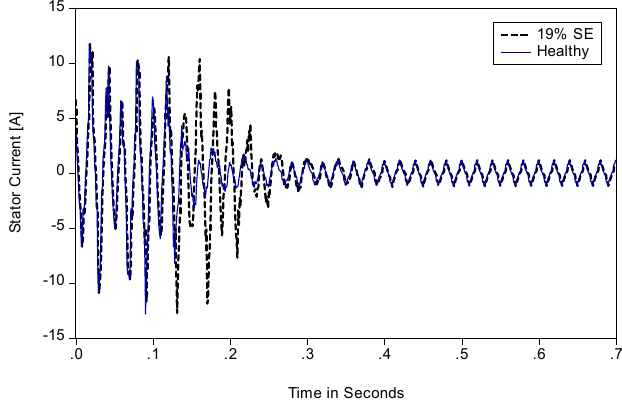
Figure 10. Stator Current for a load of 2.1 N ∙ m and 19% eccentricity.